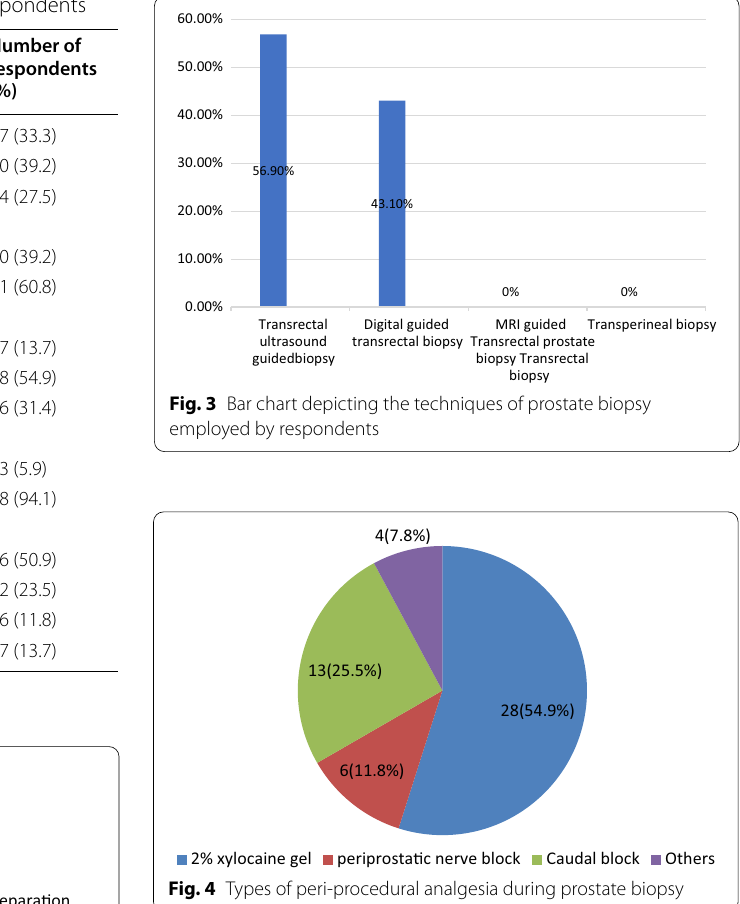
Fig. 4 Types of peri-procedural analgesia during prostate